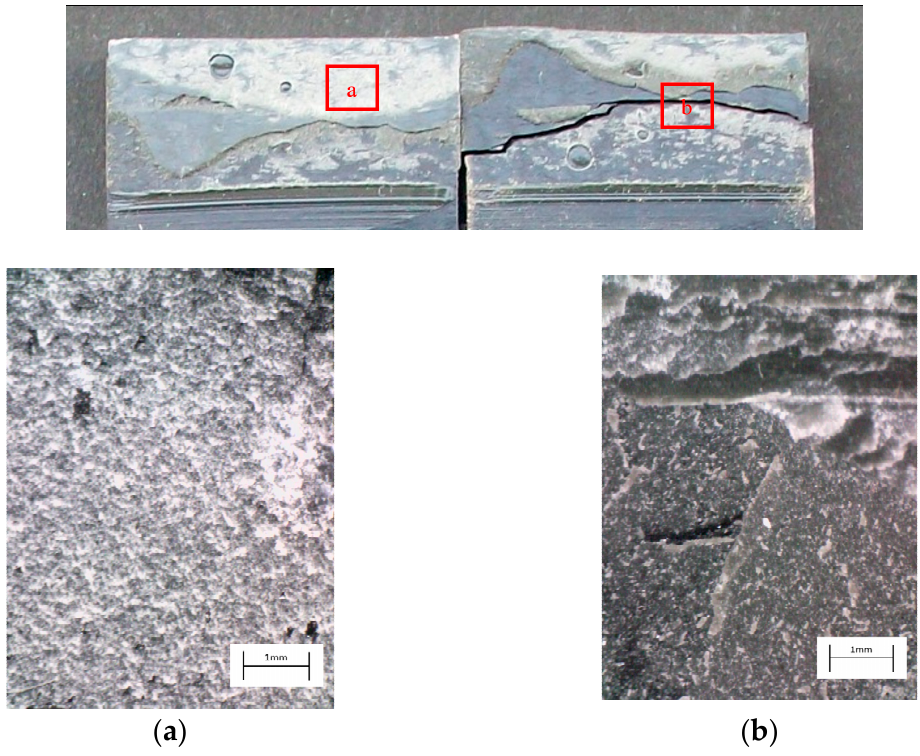
Figure 10. Fracture surface of a specimen pretreated with APPT with D = 5 mm and v = 100 mm/s and subjected to quasi-static tensile test, with magnified details ( a ) and ( b ) acquired by micro- scope.